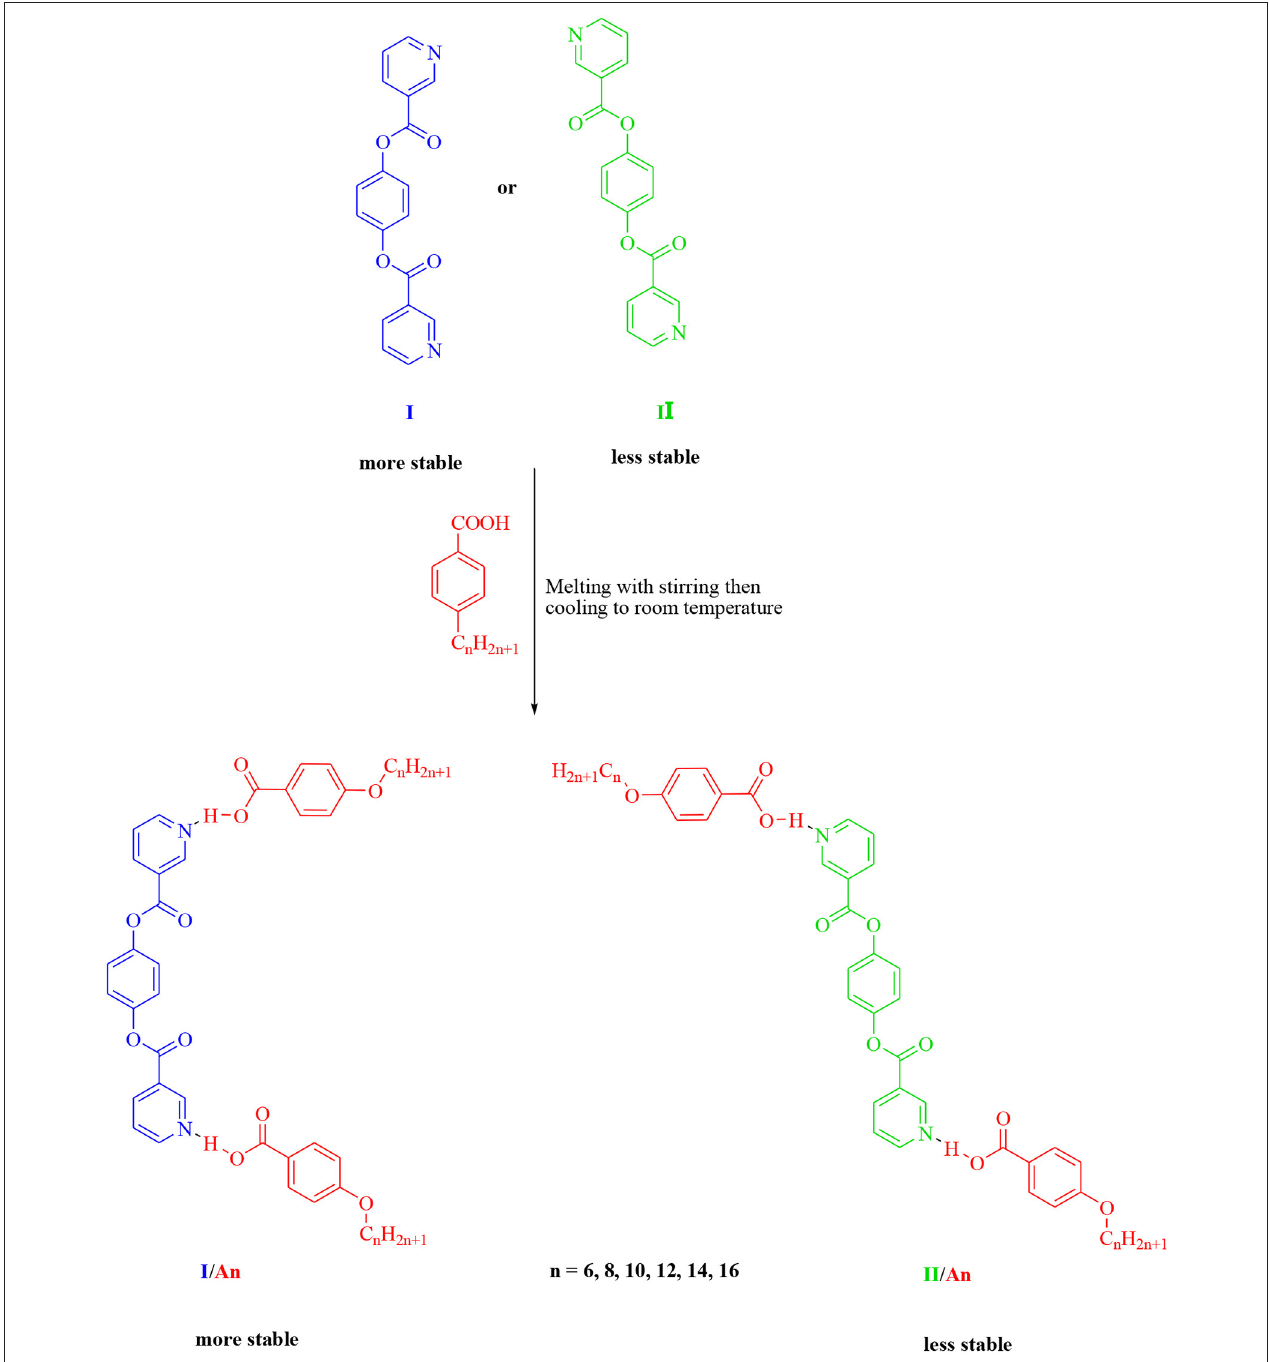
the greater co-linearity of this complex which results in more efficient packing in the solid crystal phase, in addition to the enhanced molecular interactions between the ester linkages. The stabilities of the smectic A and smectic C are also both affected by the increase of the acid alkoxy chain length ( n ) (Naoum et al.,